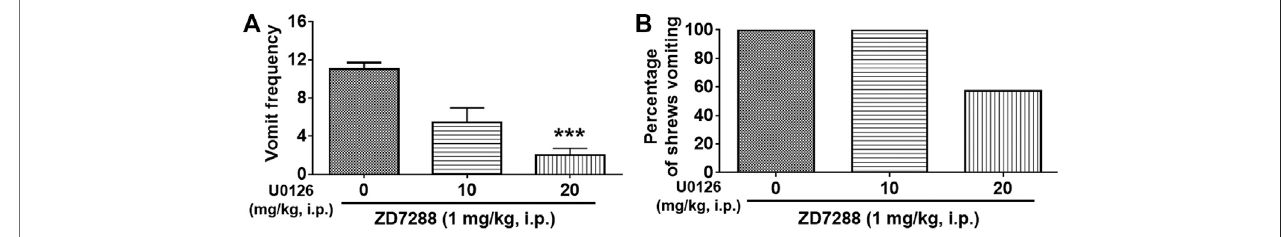
FIGURE9| EffectofERK1/2inhibitorU0126ontheHCNchannelblockerZD7288-inducedemesis.Differentgroupsofshrewsweregivenvehicleorvaryingdoses of the ERK1/2 inhibitor U0126 (i.p.) ( n (cid:2) 7 shrews per group), 30 min prior to ZD7288 (1 mg/kg, i. p.) administration. Shrews were observed the next 30 min. (A) The frequency of emesis was analyzed with Kruskal-Wallis non-parametric one-way ANOVA followed by Dunnett ’ s post hoc test and presented as mean ± SEM. (B) Percentage of shrews vomiting was analyzed with chi-square test and presented as mean. *** p < 0.001 vs. 0 mg/kg.